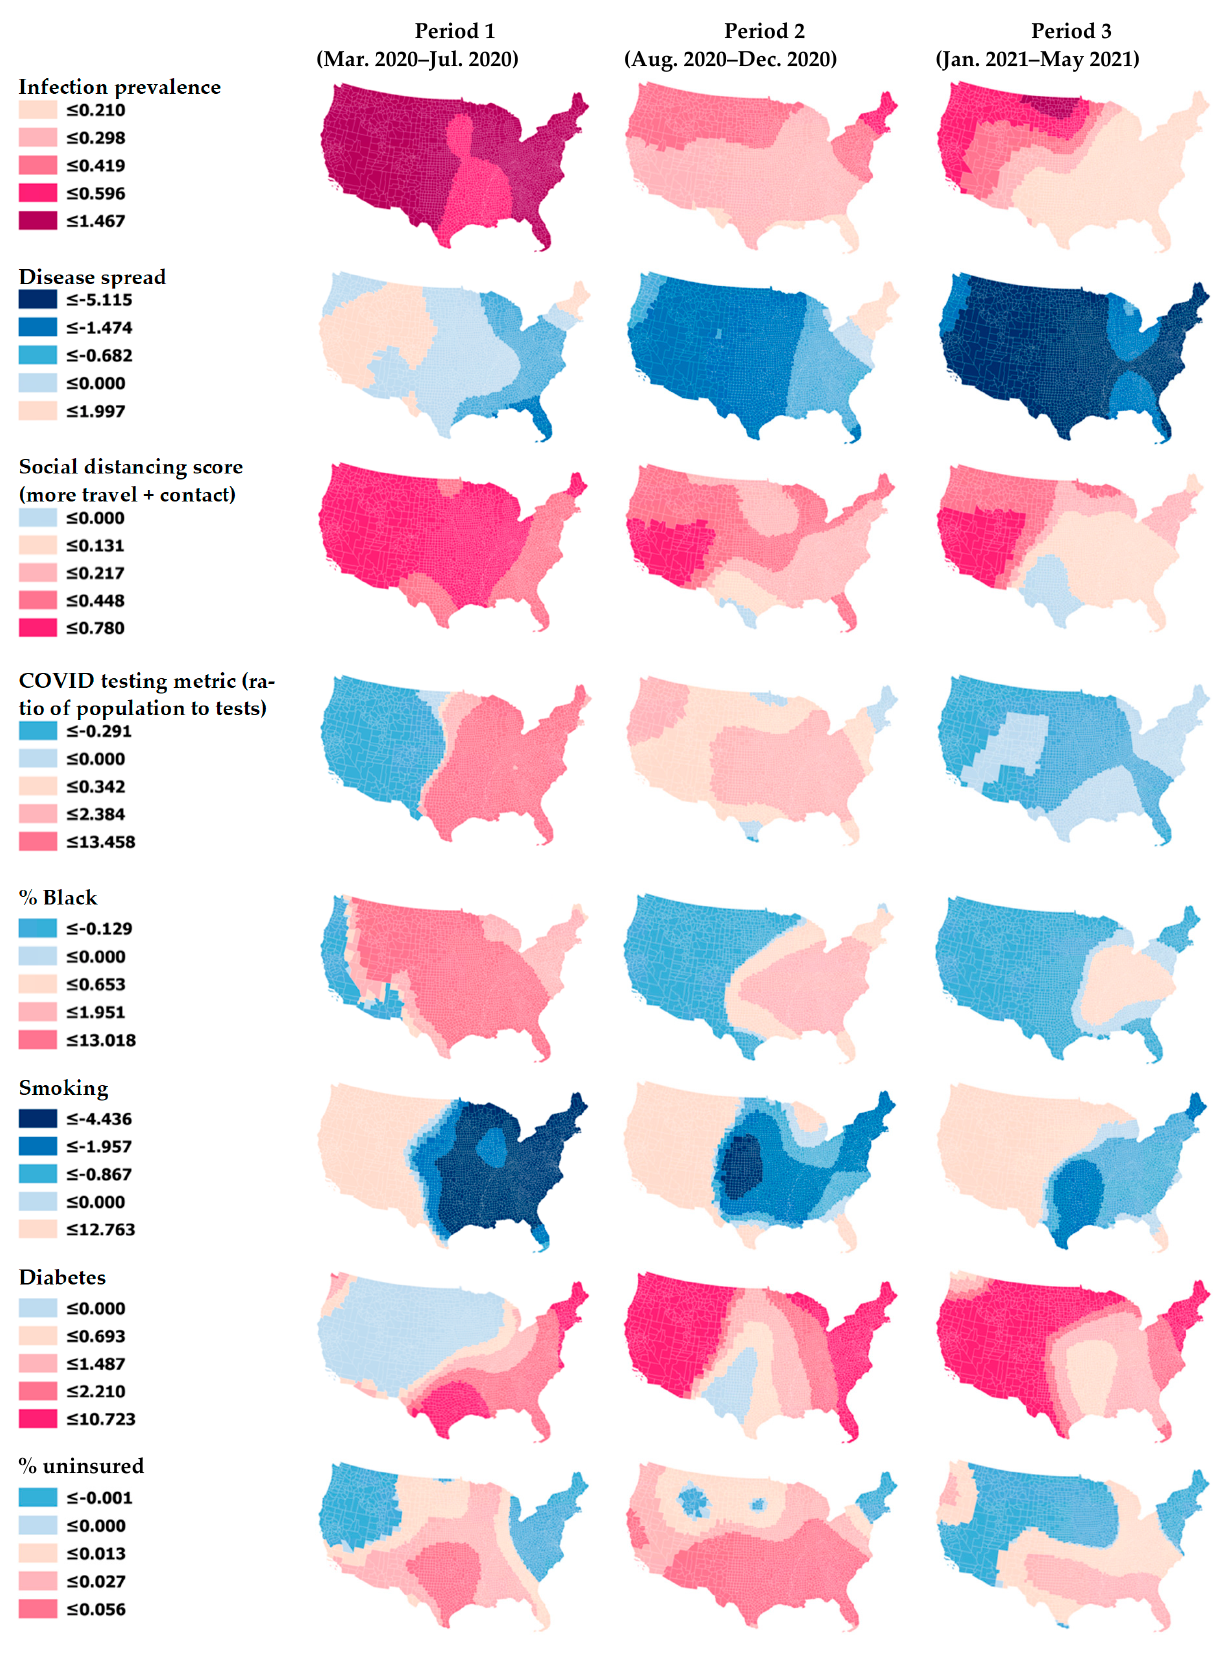
Figure 4. Spatially and temporally varying relationships between COVID-19 mortality rates and selected PVI variables. Figure 4 and Table 4 show how the coefficients of each variable fluctuate over space and time. Taking the social distancing variable as an example, the effect of less social dis- tancing (i.e., a higher social distancing score reflects more travel and contact) on COVID- 19 mortality rates was strongest in the early phase of the pandemic, but it was later atten- uated as the pandemic wore on and the compliance waned and became uneven (Figure